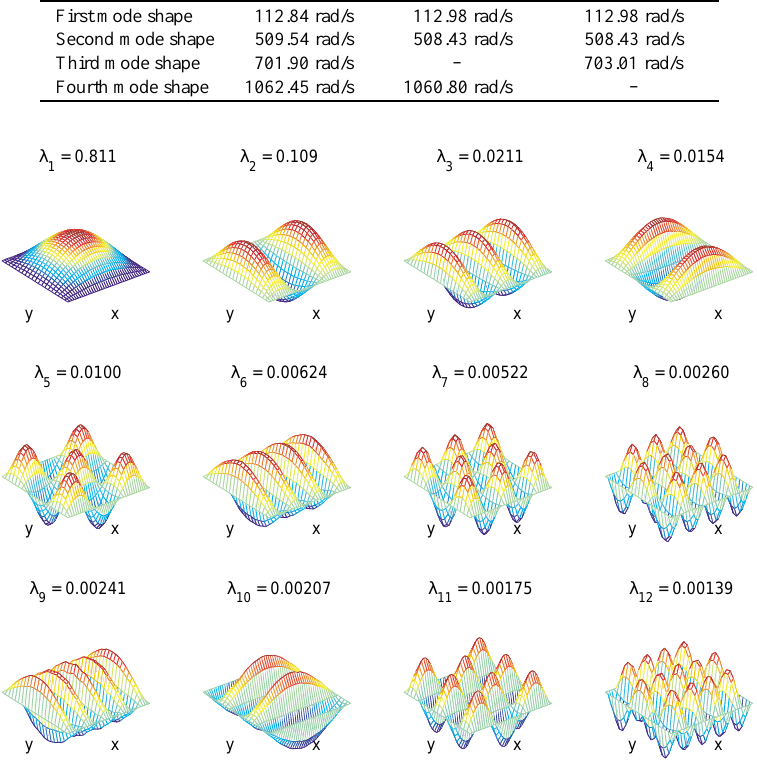
Fig. 11. First twelve POMs for impulsive force applied at the middle of